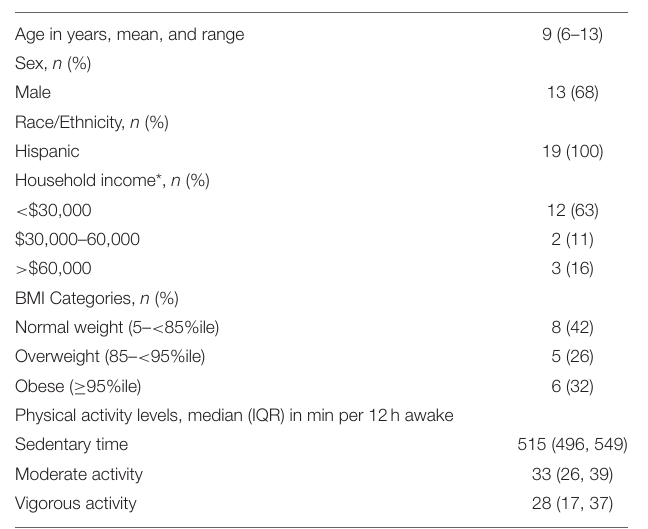
TABLE 1 | Baseline demographics ( n = 19).